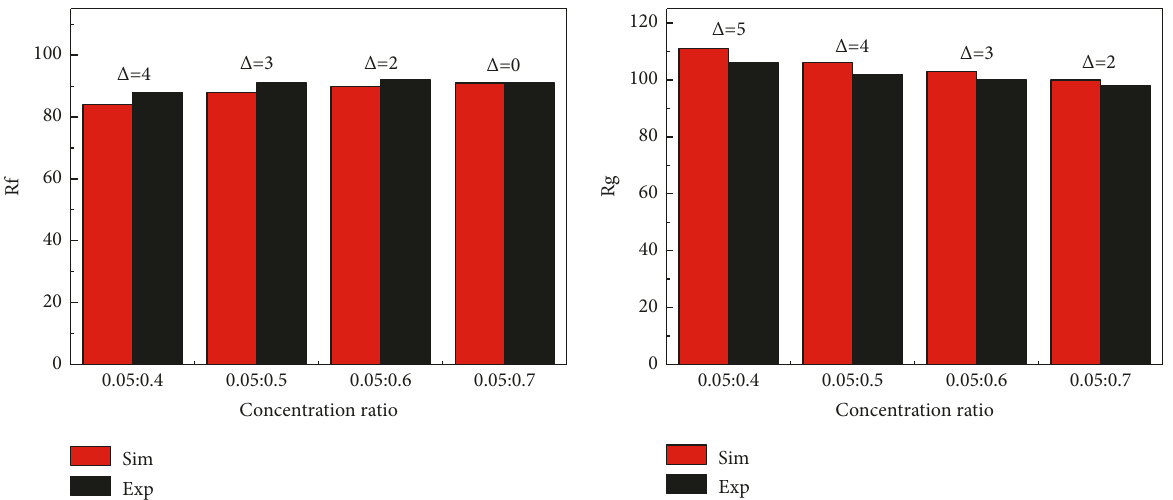
Figure 16: Comparison of R